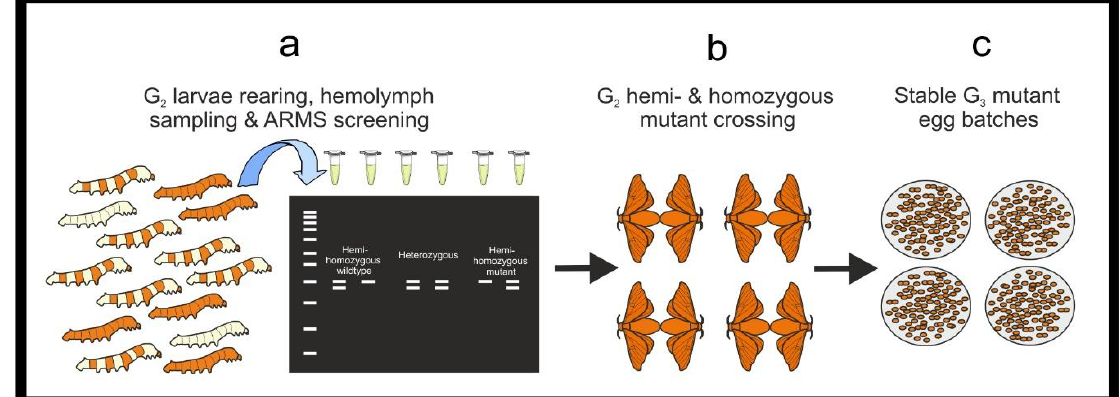
Figure 5. A workflow for ARMS screening of G 2 larvae and establishment of a stable mutant line. ( a ) G 2 larvae are reared to the 5th instar and ARMS-PCR is performed on DNA purified from their hemolymph. G 2 hemi- and homozygous mutant larvae are reared until adult stage and ( b ) bred to generate ( c ) G 3 lines stably inheriting the